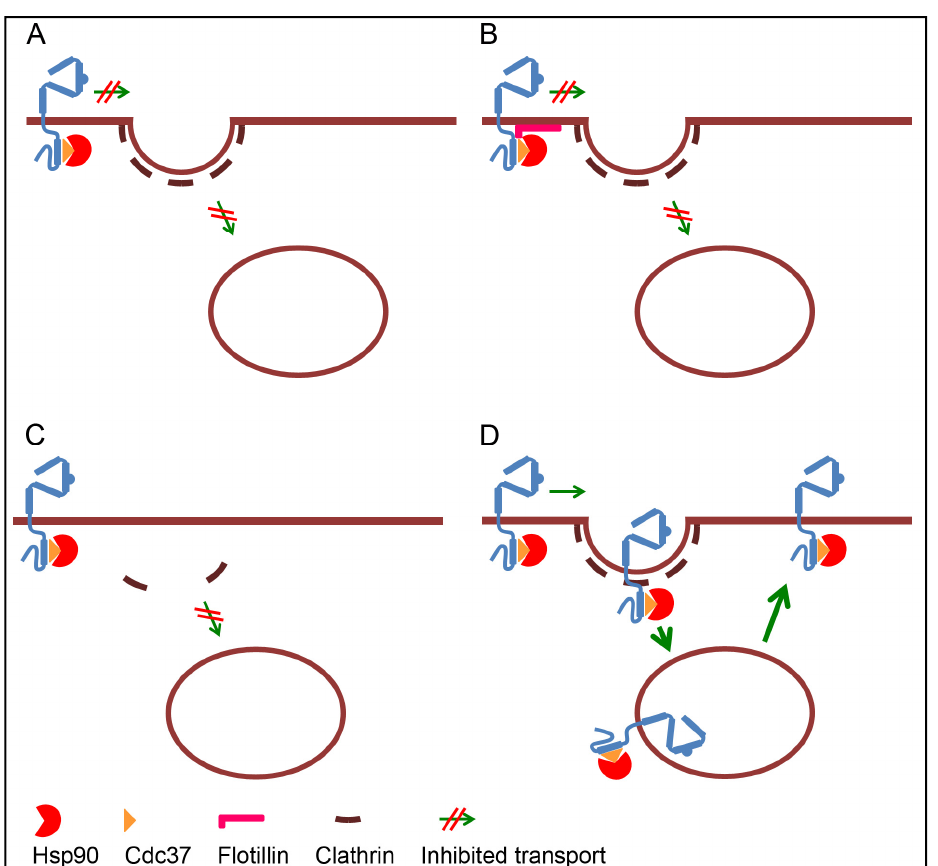
Figure 2. Four models for ErbB2 resistance to down-regulation. ( A ) Internalization of ErbB2 is restricted due to a lack of internalization signals, or because interaction with Cdc37-Hsp90 induces a conformation where internalization signals are hidden; ( B ) ErbB2 is retained at the plasma membrane due to interaction with proteins like flotillins and possibly other raft components; ( C ) Expression of ErbB2 inhibits the formation of clathrin-coated pits; ( D ) Internalization of ErbB2 is not inhibited, but ErbB2 in endosomes recycles rapidly back to the plasma membrane. Interaction with Hsp90 has been suggested to sequester ErbB2 homodimers, but for simplicity only monomeric ErbB2 is drawn in the figure. Different internalization pathways may be involved, but also for simplicity, only clathrin-dependent internalization is